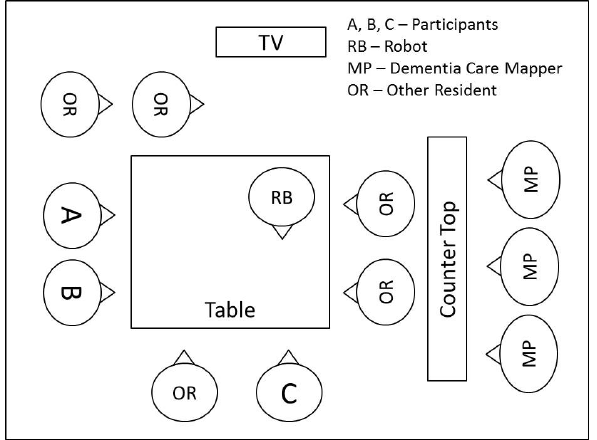
Figure 2. Room Layout during Assessment